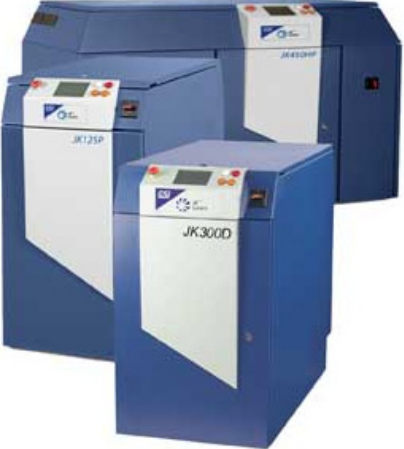
Figure 5. Right picture: Nd:YAG solid pulse source, type GSI JK (JK Lasers, Rugby, UK) used in the experiment [57].